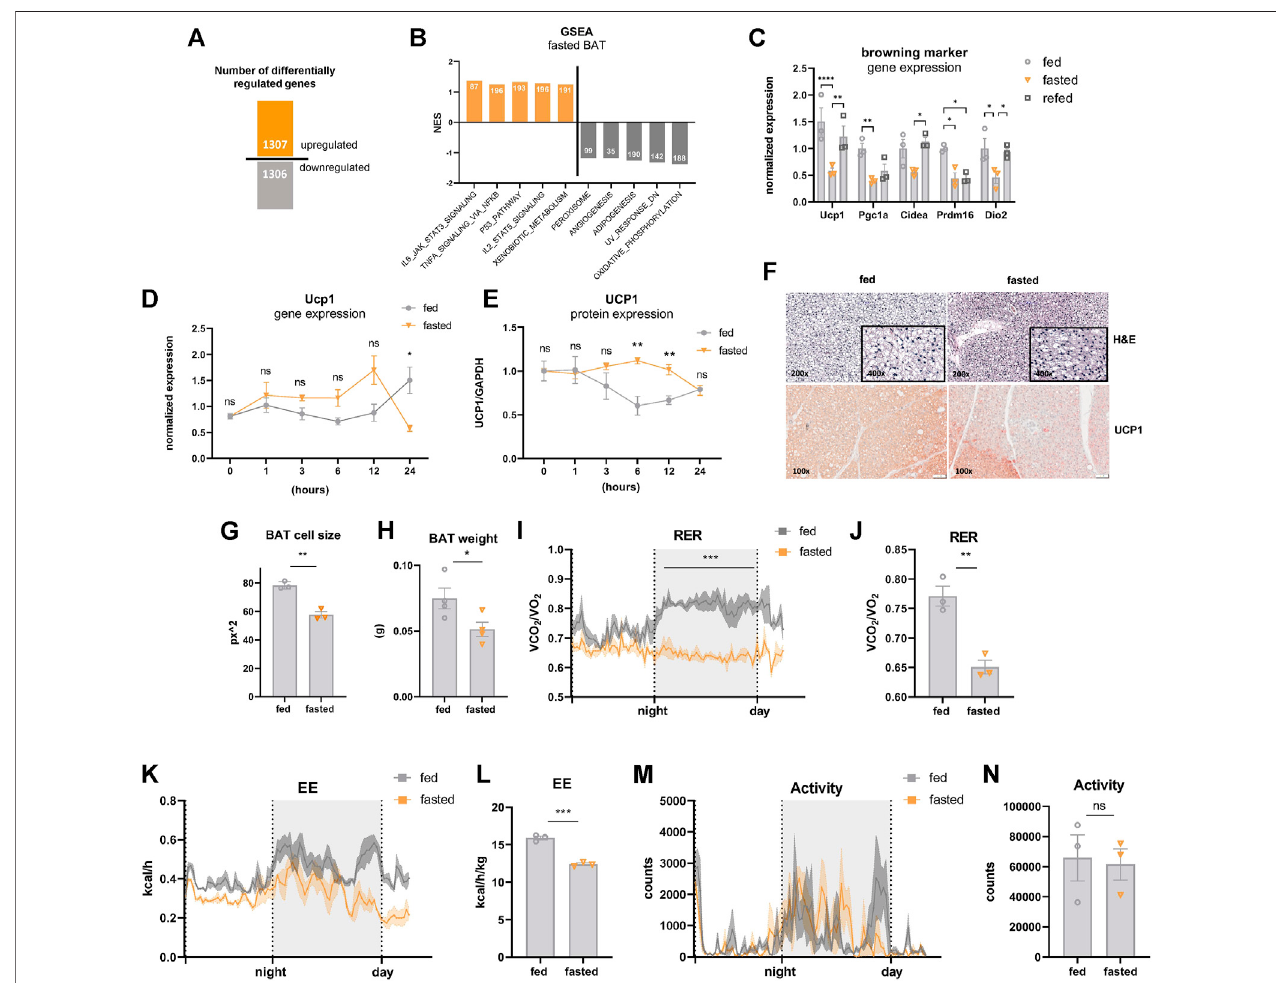
FIGURE 1 | Acute fasting-mediated alterations in BAT of mildly cold-stressed mice. (A) Number of up- and downregulated (1.5 x, FDR5) genes in BAT of 24 h fasted mice. (B) GSEA Hallmark analysis results with top fi ve pathways with highest or lowest normalized enrichment scores (NES). Numbers of mapped genes are shown in the bars. (C) BAT mRNA expression of genes encoding for browning markers of ctrl, 24 h fasted, and 4 h refed mice. (D) Ucp1 mRNA and (E) UCP1 protein expression (from WES digital western blotting) in BAT harvested after 1, 3, 6, 12, and 24 h of fasting with samples from circadian-matched ad libitum fed controls. GAPDH served as loading control. (F) Representative images (magni fi cation, ×100) of BAT of ctrl and 24 h fasted mice stained with hematoxylin and eosin (E – H) and immunohistochemistry with anti-UCP1 antibody. (G) Cell size of was analyzed by using ImageJ and indicated as square pixels (px 2 ). (H) BAT weight in grams (g) of ctrl and 24 h fasted mice. (I,J) Respiratory exchange ratio (RER), (K,L) energy expenditure (EE), and (M,N) motility of ctrl and 24 h fasted mice as validated by indirect calorimetry in metabolic cages. Data are presented as mean values ± SEM. Signi fi cant differences in the mRNA expression of fed, fasted, and refed mice were analyzed by 2-way ANOVA and Tukey ’ s multiple comparisons test, for BAT weight, RER and energy expenditure unpaired t - test was performed. Differences not indicated with asterisks or indicated with ns are not statistically signi fi cant ( p > 0.05). *** p < 0.001, ** p < 0.01, and * p < 0.05.